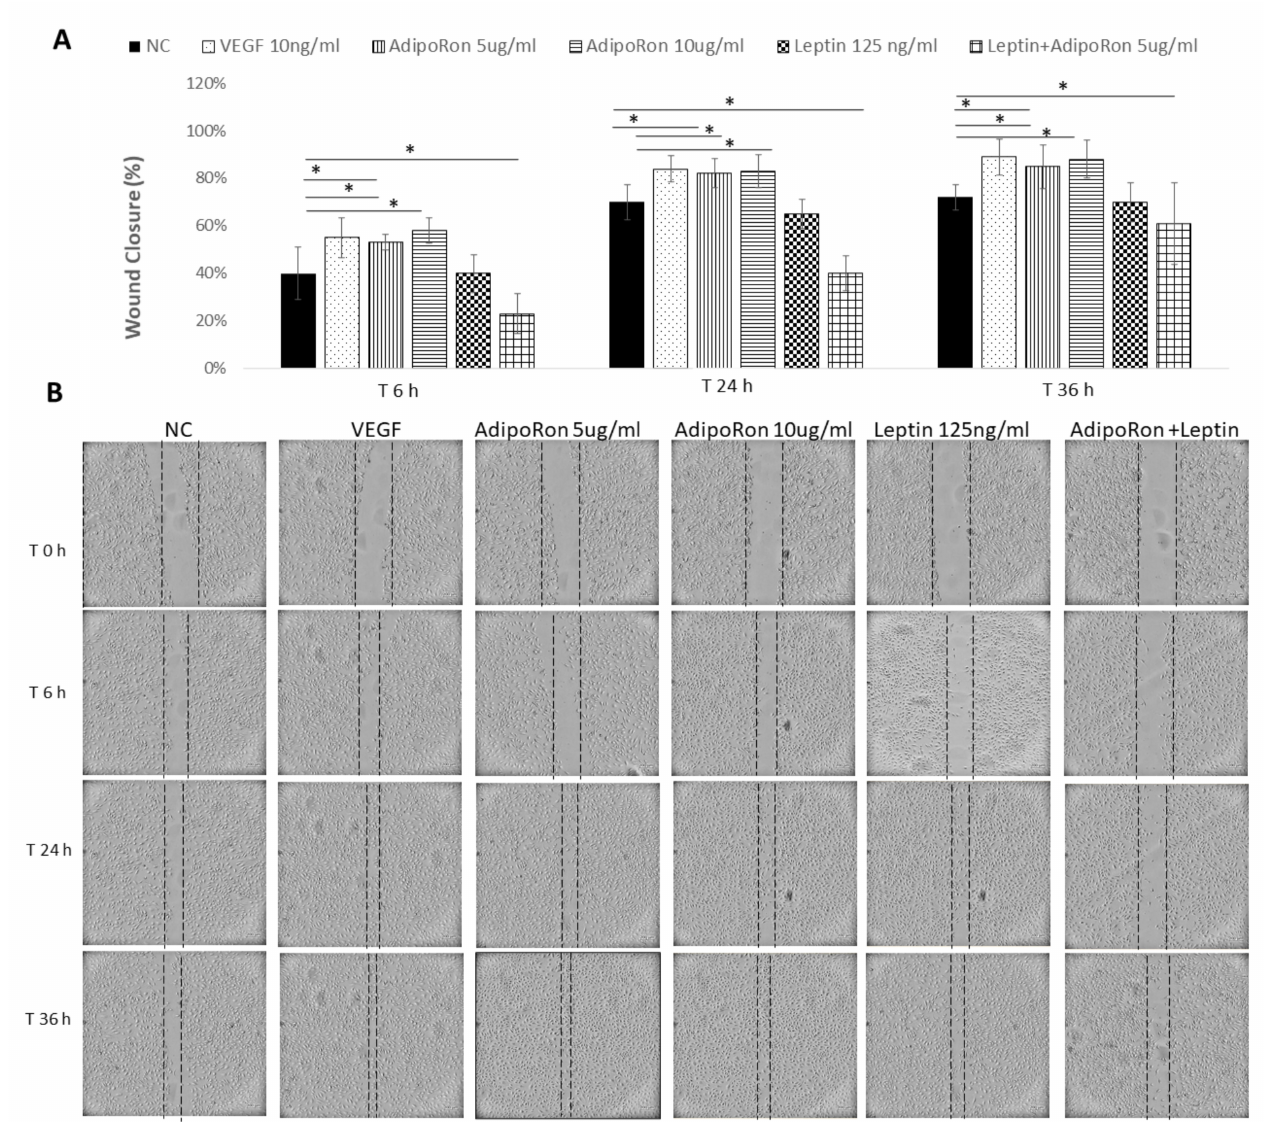
Figure 3. AdipoRon and Leptin exert antagonizing effects on cell migration. HUVEC endothelial cells were subject to a scraped wound and, next, treated with two different doses of AdipoRon (5 or 10 µ g/mL) or Leptin (125 ng/mL) alone or in combination. Cells were photographed immediately following the scratch (0 h), and after 6, 24 and 36 h. Untreated cells were considered as the negative control; cells treated with VEGF-A (10 ng/mL) was considered as a positive control. ( A ) Wound closure was measured by calculating pixel densities in the wound area and expressed as percentage of wound closure ± SD. * p < 0.05. ( B ) Representative figures are shown from one of two independent